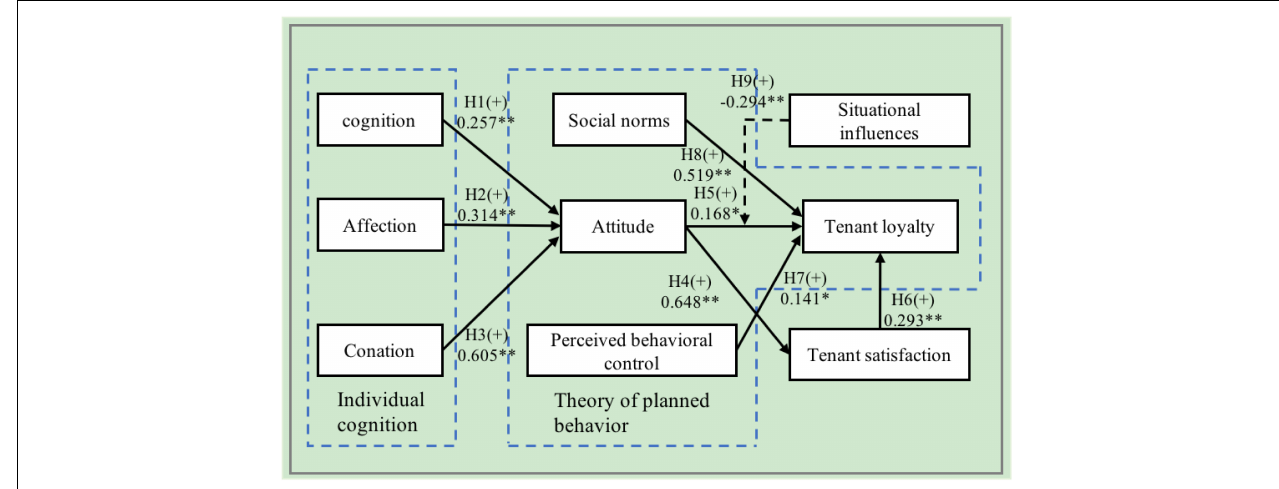
FIGURE 2 | The theoretical structural equation model with standardized